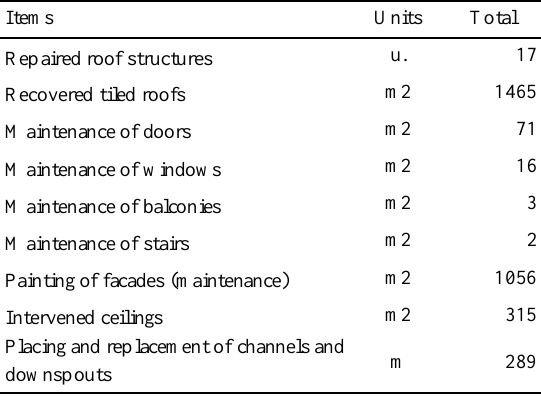
Table 2. Total quantities of the main items carried out during the “Herrerías” Maintenance Campaign during May and Agosto of